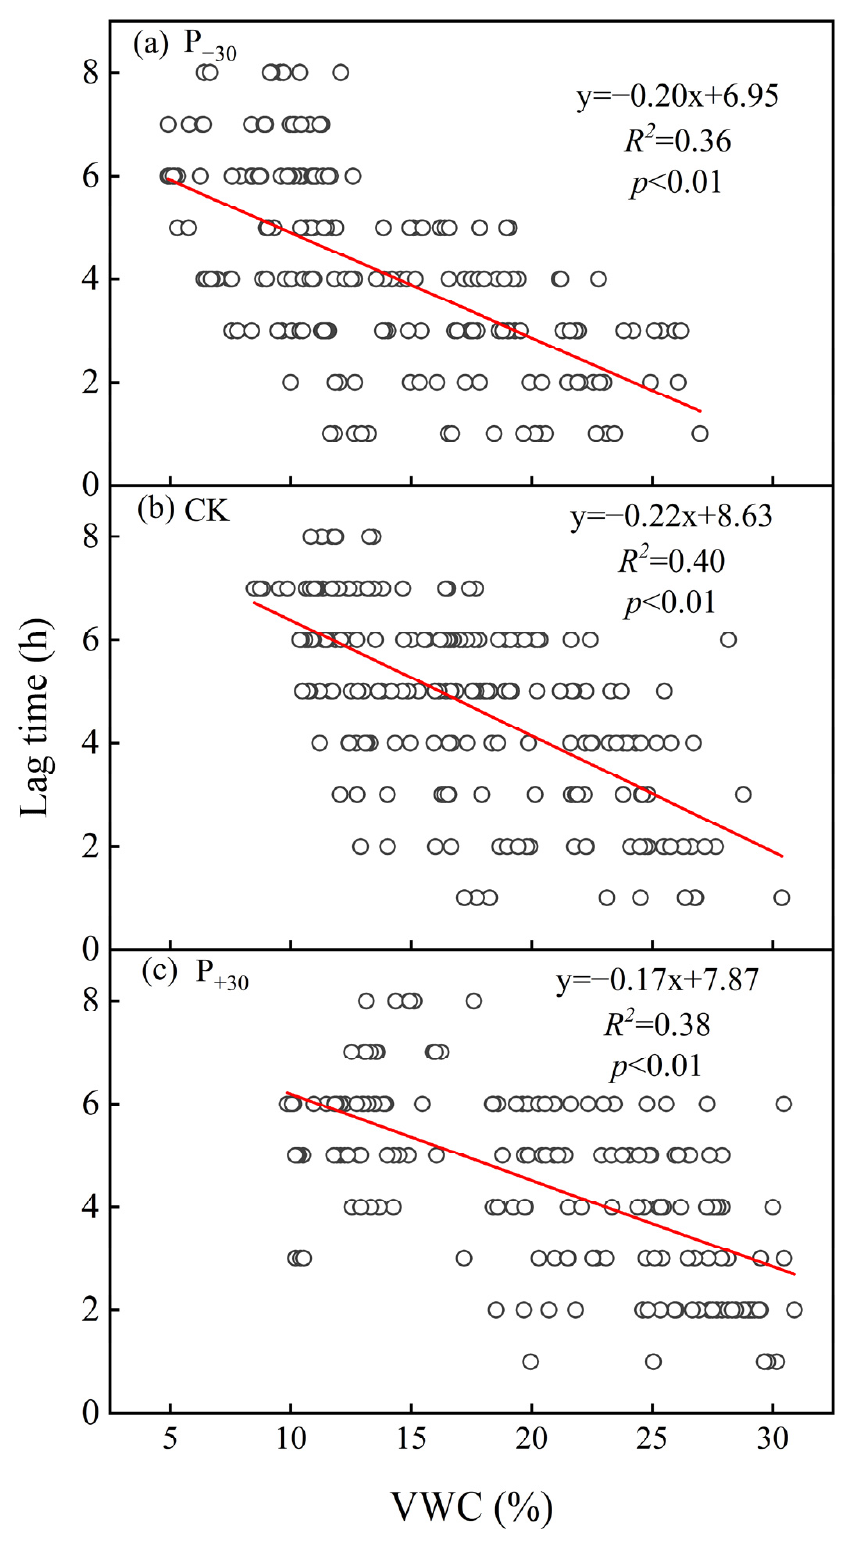
Figure 6. Relationship between soil volumetric water content (VWC) and lag time in three precipi- tation treatments (P − 30 ( a ), CK ( b ) and P +30 ( c )) and VWC at 10 cm soil depth. The lag times were calculated by a cross-correlation analysis using a three-day moving window with a one-day step. The solid line is fitted using linear regression.